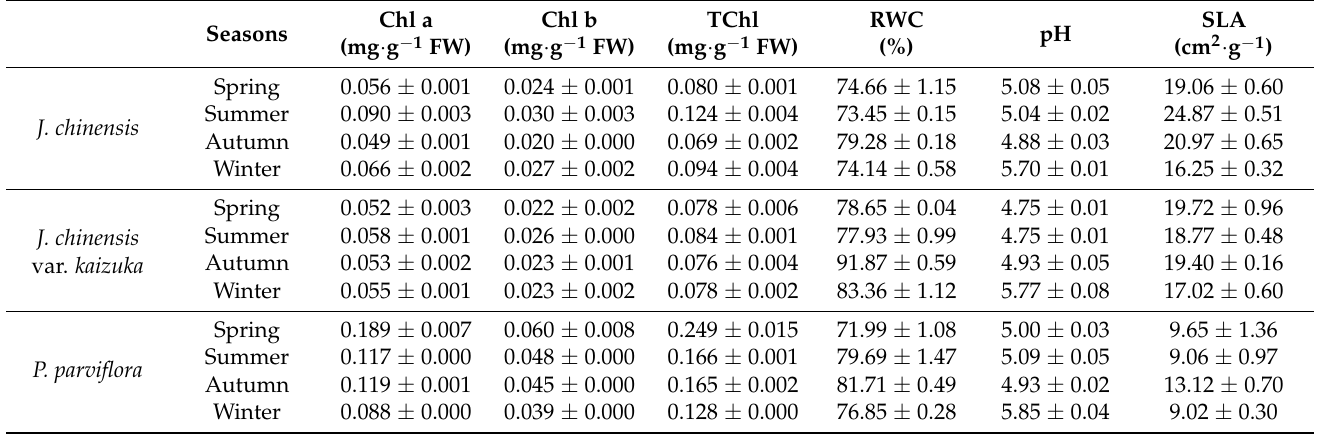
Table 3. The leaf traits of 24 plant species in four different seasons (spring, summer, autumn, and